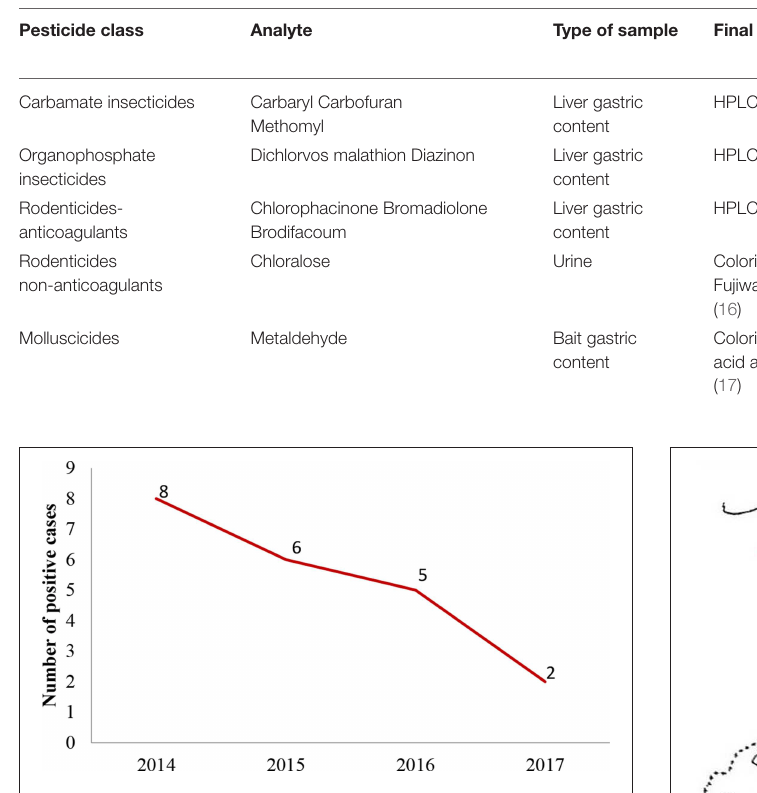
FIGURE 2 | Yearly distribution of confirmed animal poisoning from 2014 to 2017.